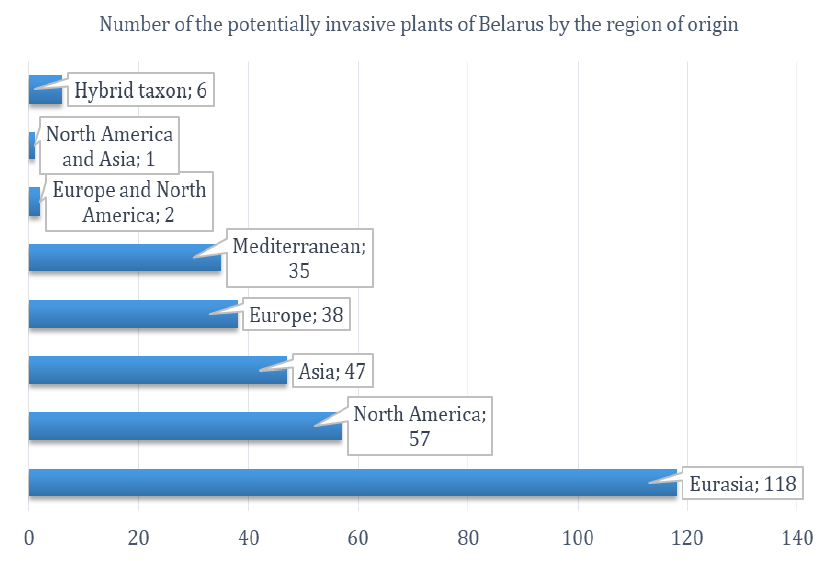
Fig. 3. Natural area (origin) of the potentially invasive plant species of